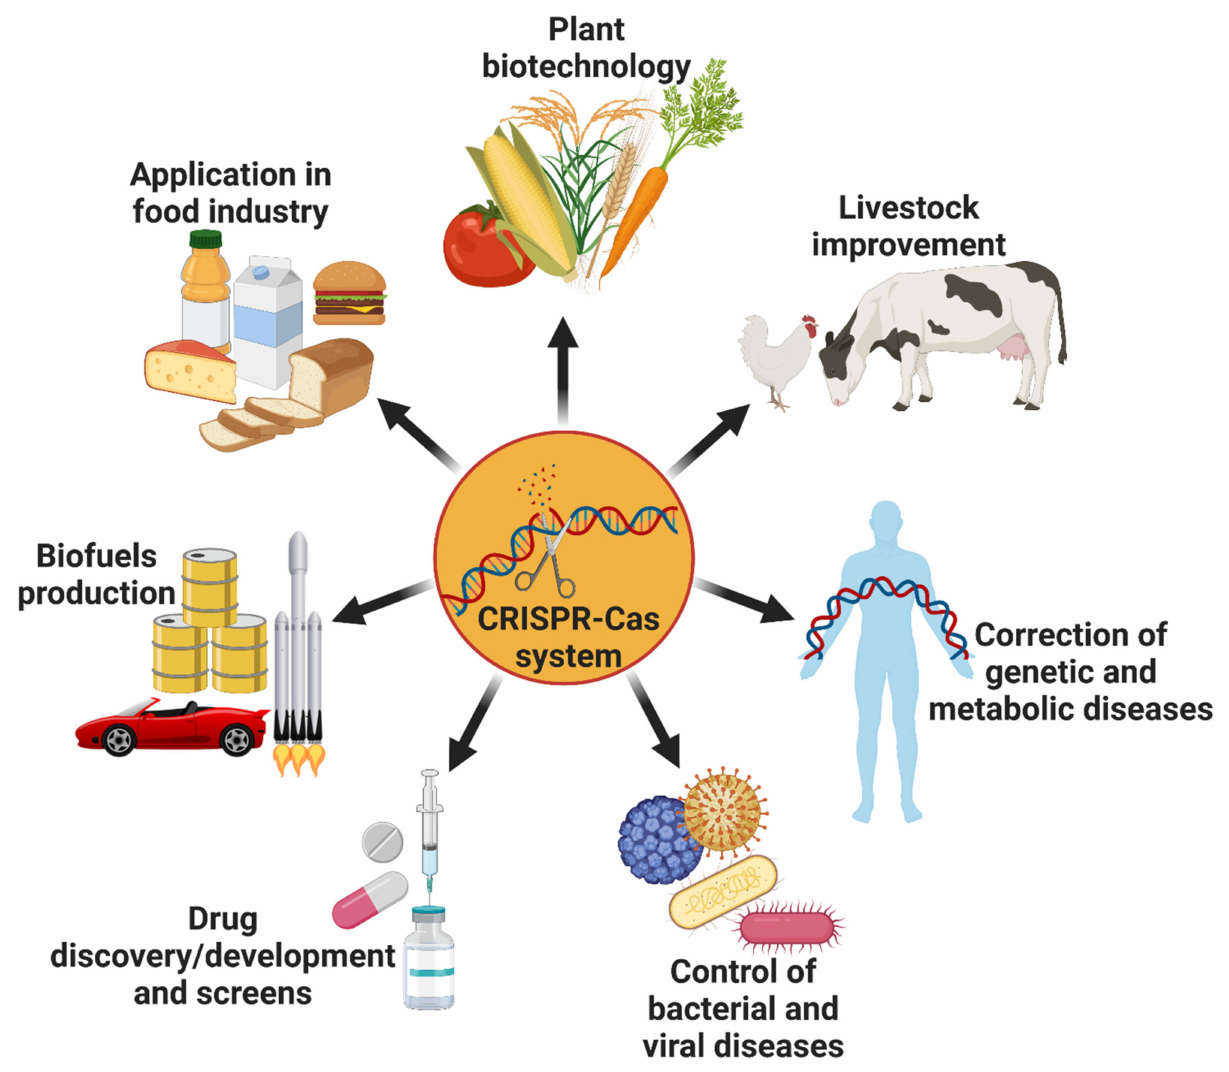
Figure 8. Applications of the CRISPR–Cas technology in various